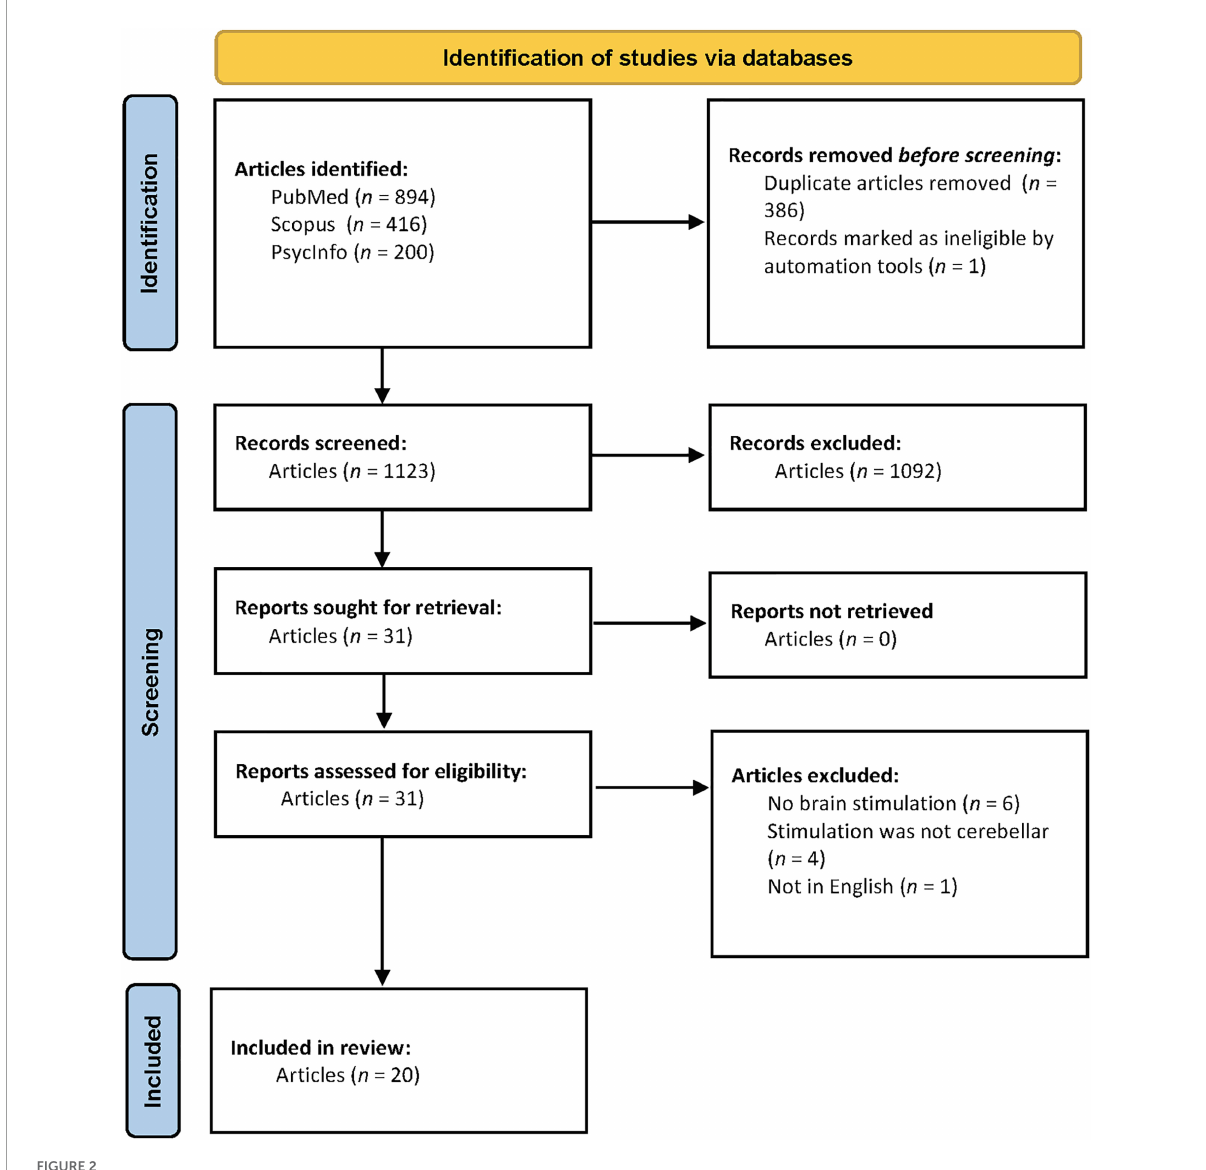
FIGURE2 PRISMA flow diagram regarding study inclusion and